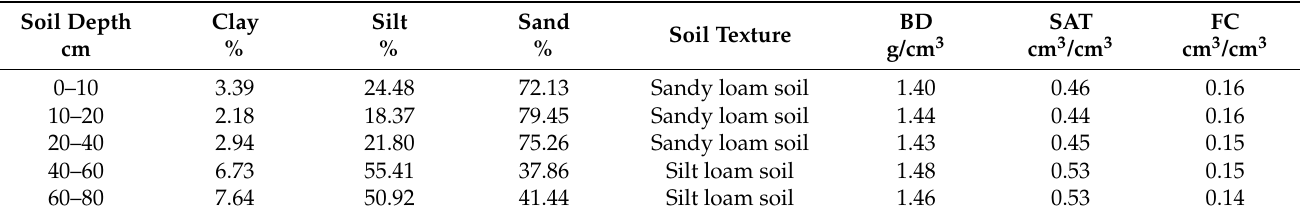
Table 1. Physical properties of soil.